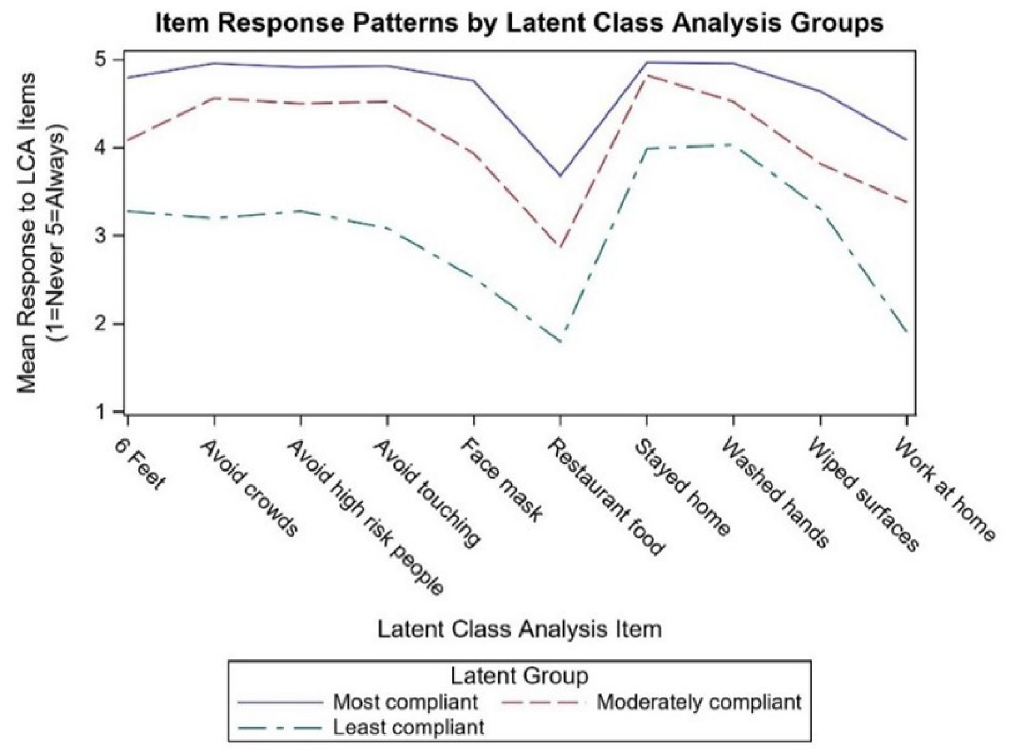
Fig 1. Chosen COVID-19 mitigation behaviors response patterns by latent class analysis class.